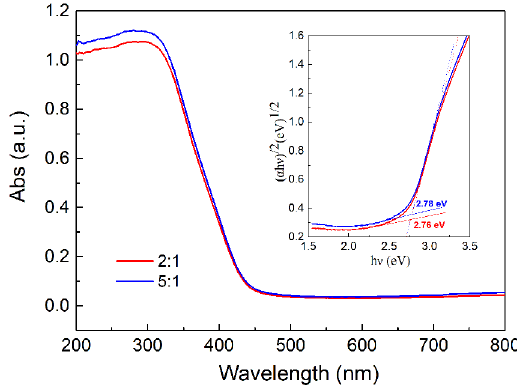
Figure 5. UV-Vis diffuse reflectance spectra of samples synthesized with different salt amount.